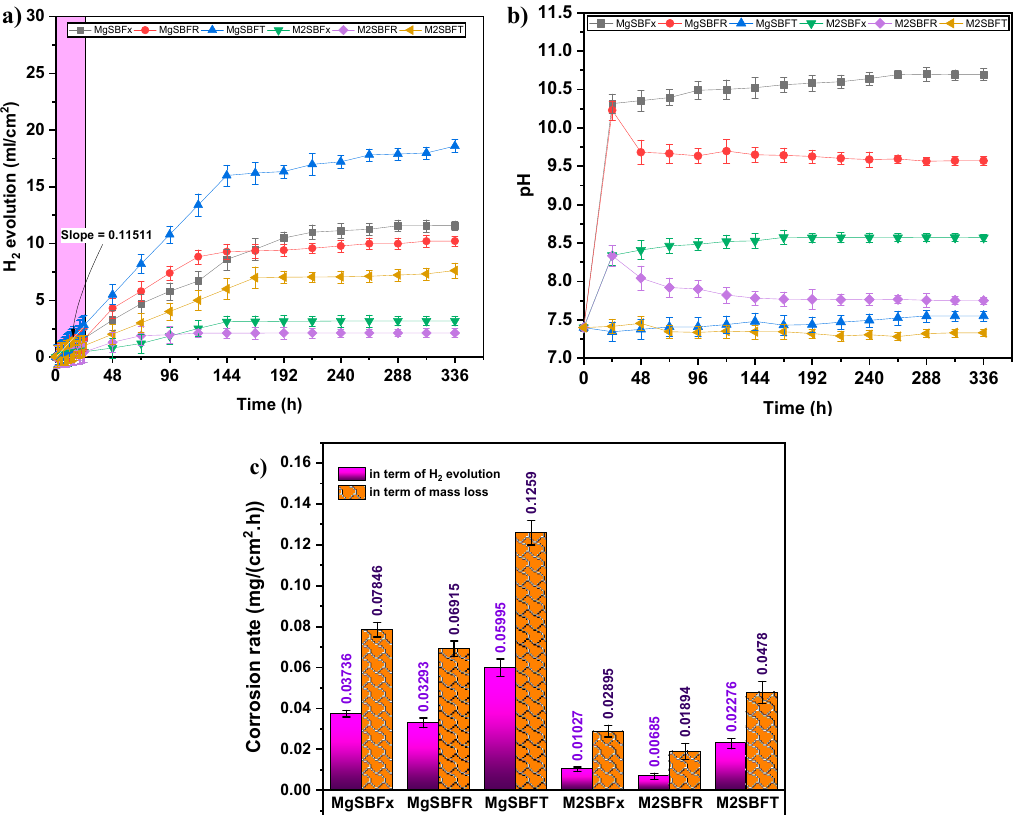
Figure 7. Immersion test results of CP Mg and Mg-1.0Ca-0.5Sr alloy in r-SBF corrosion media. ( a ) H 2 evolution curves in different pH-regulating treatments, ( b ) time dependant pH change, and ( c ) corrosion rate in terms of mass loss and evolved H 2 . (The legends in ( a , b ) indicate the respective materials in corresponding corrosion media and treatment condition, as summarized in Table 1.)